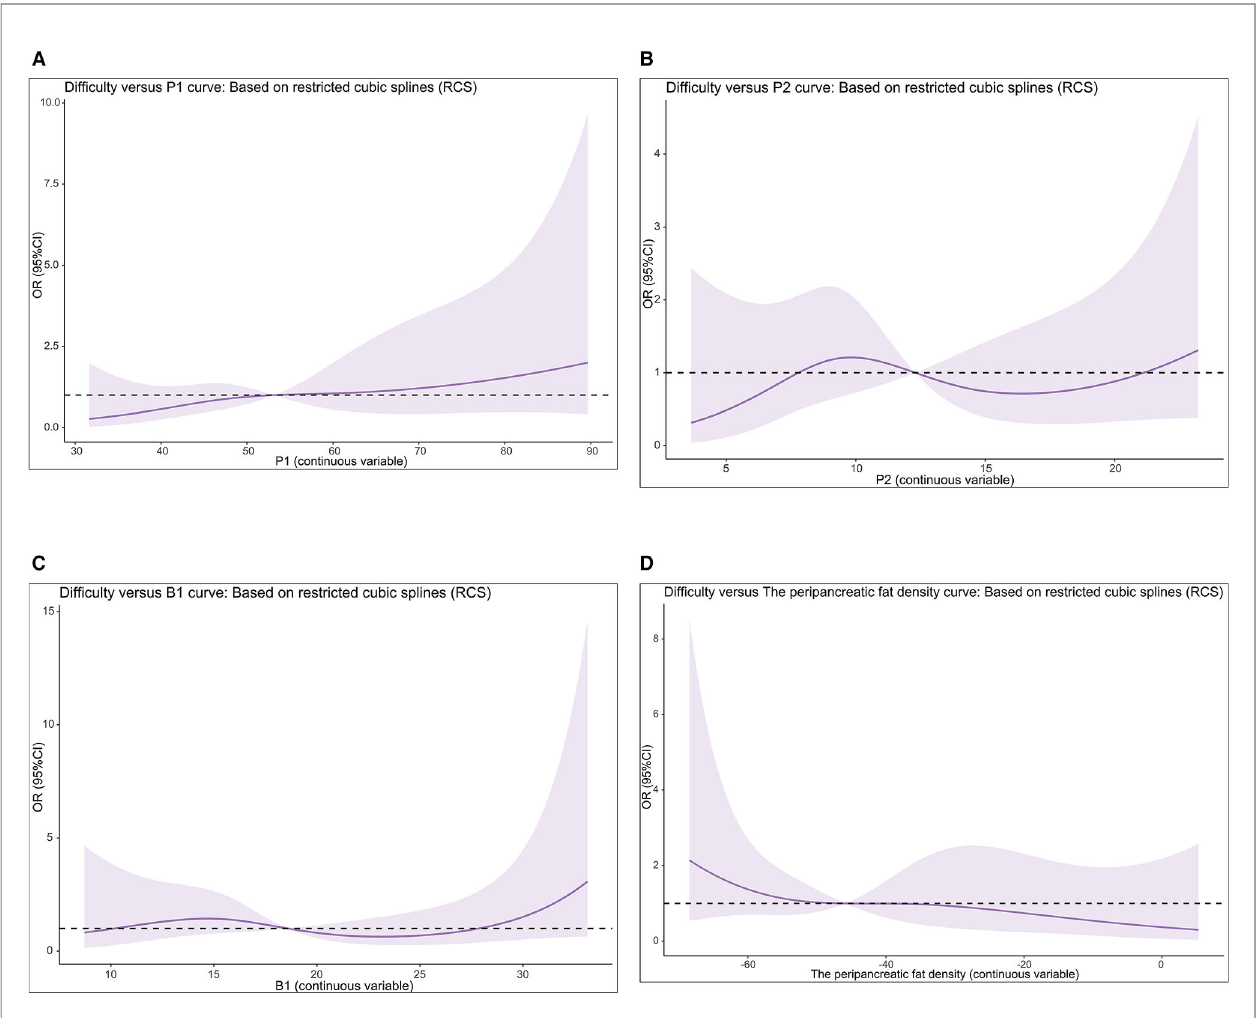
FIGURE 2 | Restricted cubic spline